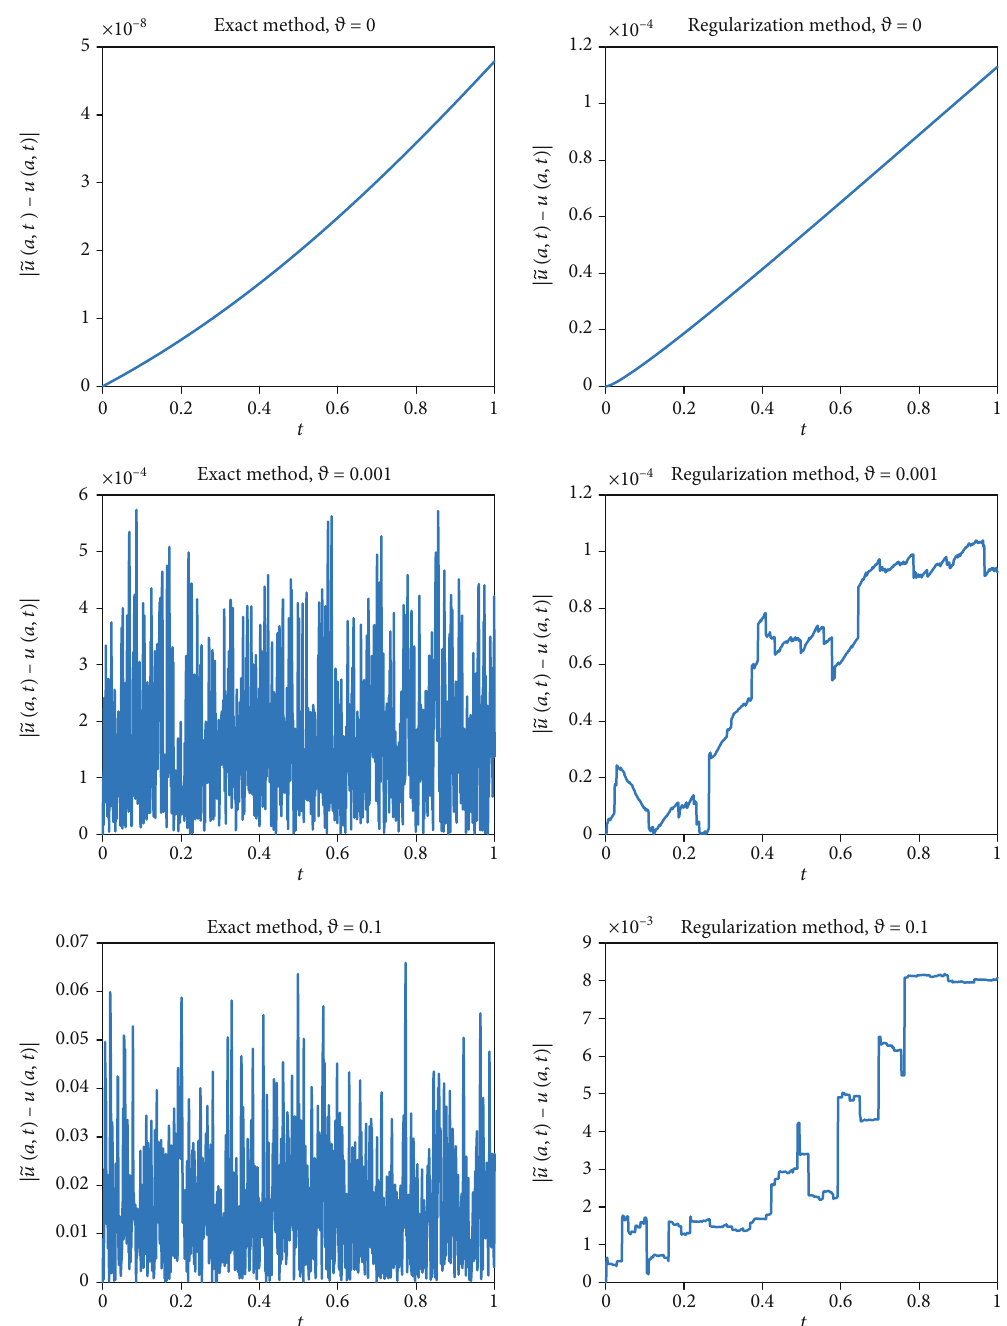
Figure 6: The absolute errors j ~ u ð a , t Þ − u ð a , t Þj , with the exact and regularization methods and di ff erent values of noises for Example 3 using Δ t = 0 : 001 and h = 0 : 05